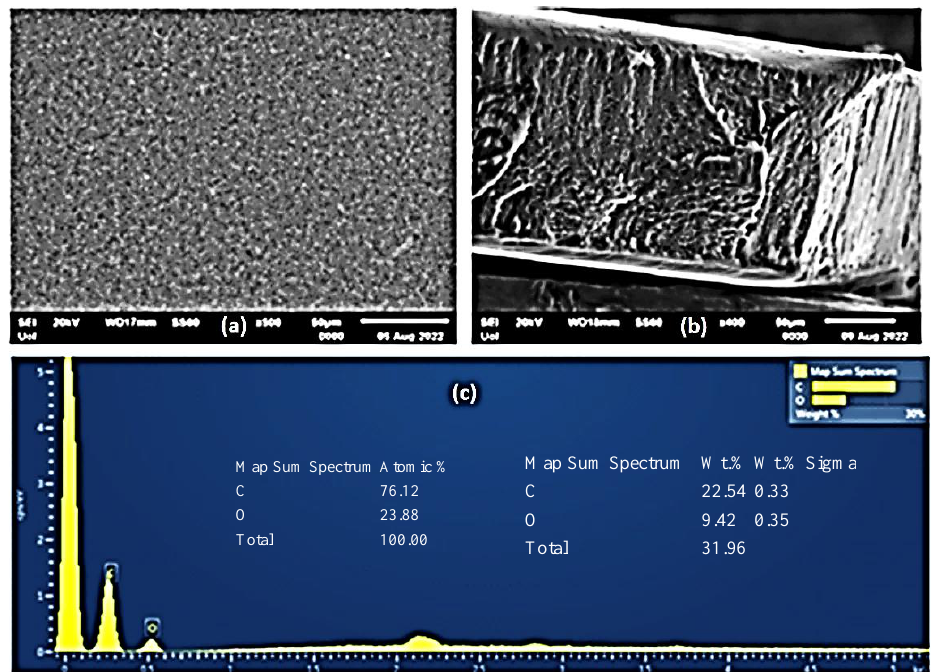
Figure 4. ( a ) SEM images of the surface and ( b ) cross-section for the pure CS/PVOH film. ( c ) Energy dispersive spectrometer (EDS) spectrum and relative elemental analysis of the surface (inset) from the SEM image ( a ).